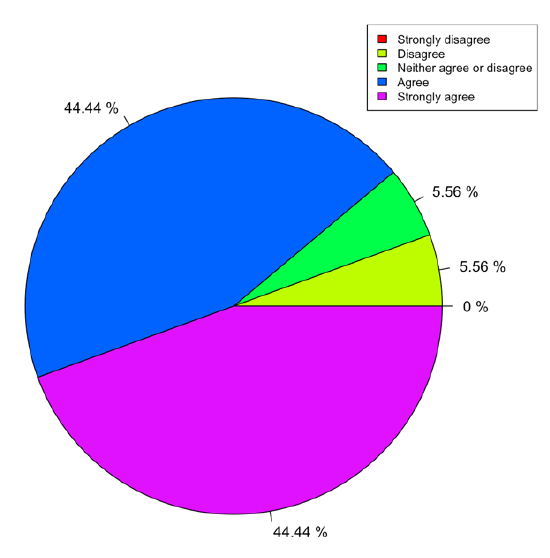
Figure 11. Survey results on students’ answers to Q12.